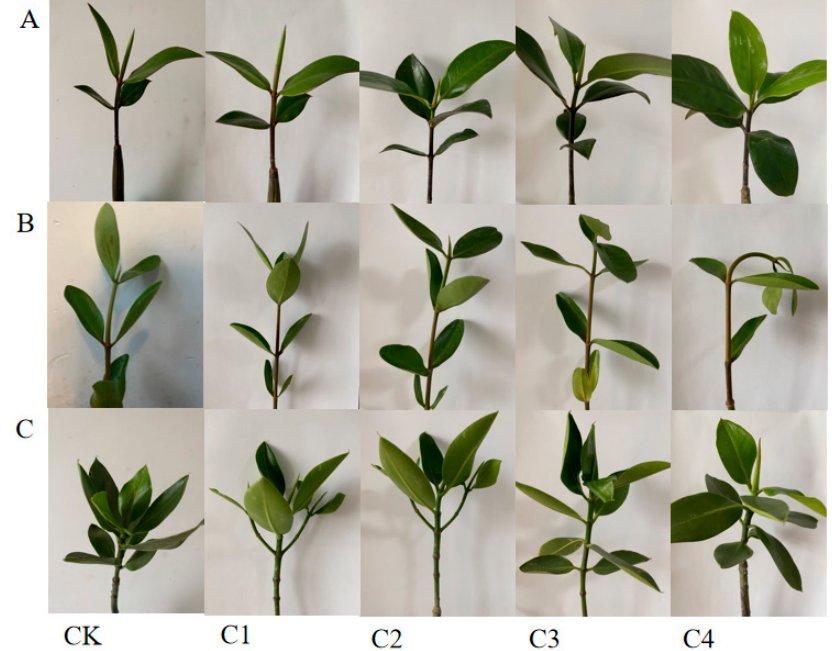
Figure 6. Morphological changes under heavy metal treatment of mangrove plants. ( A ) Bruguiera gymnorrhiza. ( B ) Kandelia obovate. ( C ) Rhizophora stylosa .